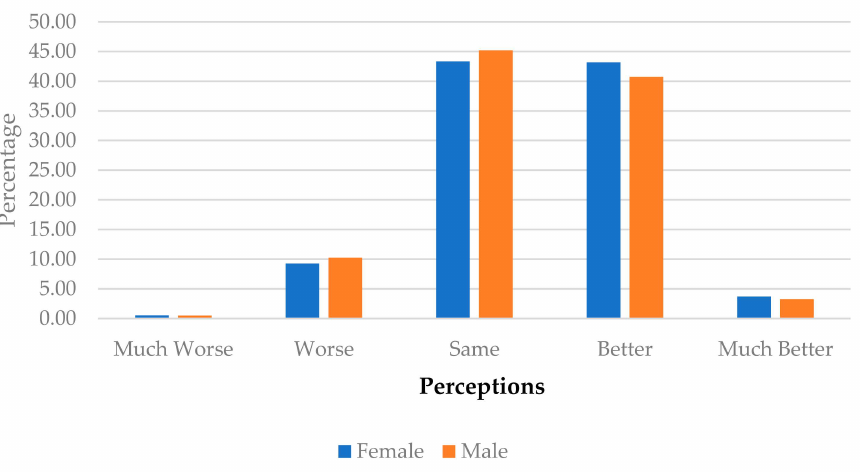
Figure 4. Perception of female and male farmers on future farming